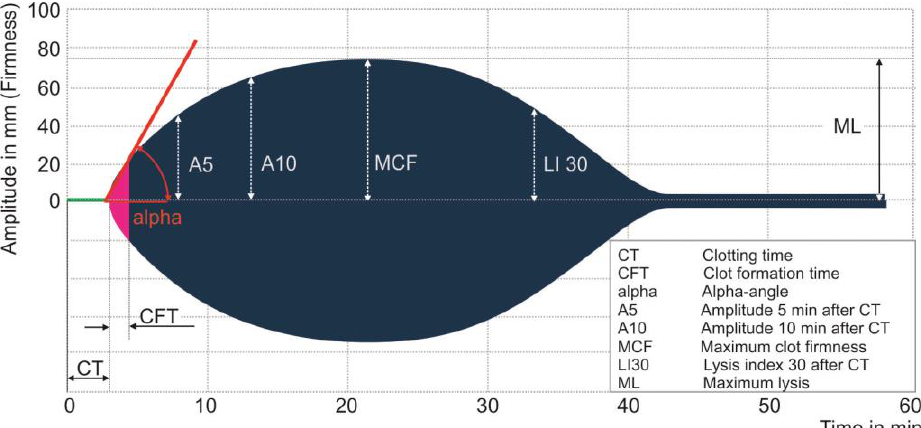
Figure 3. Picture of ROTEM ® temogram illustrating the parameters characterizing clot formation. Reprinted with the kind permission from the Instrumentation Laboratory, Bedford, MA, USA.